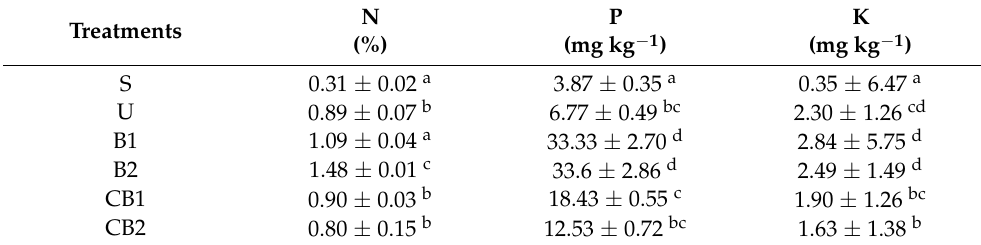
Table 10. Effects of rice straw biochar on plant nutrients concentrations of rice plant MR297 cultivar. N Treatments